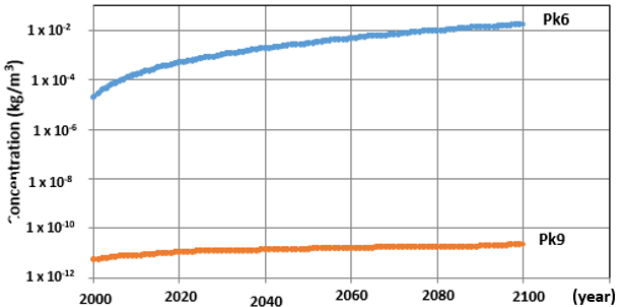
Figure A3. Concentrations variation at monitoring piezometers P1 and P6 (100 m from the coast) under RCP scenario 4.5. L1: layer 1; L9: layer 9; L18: layer 18.